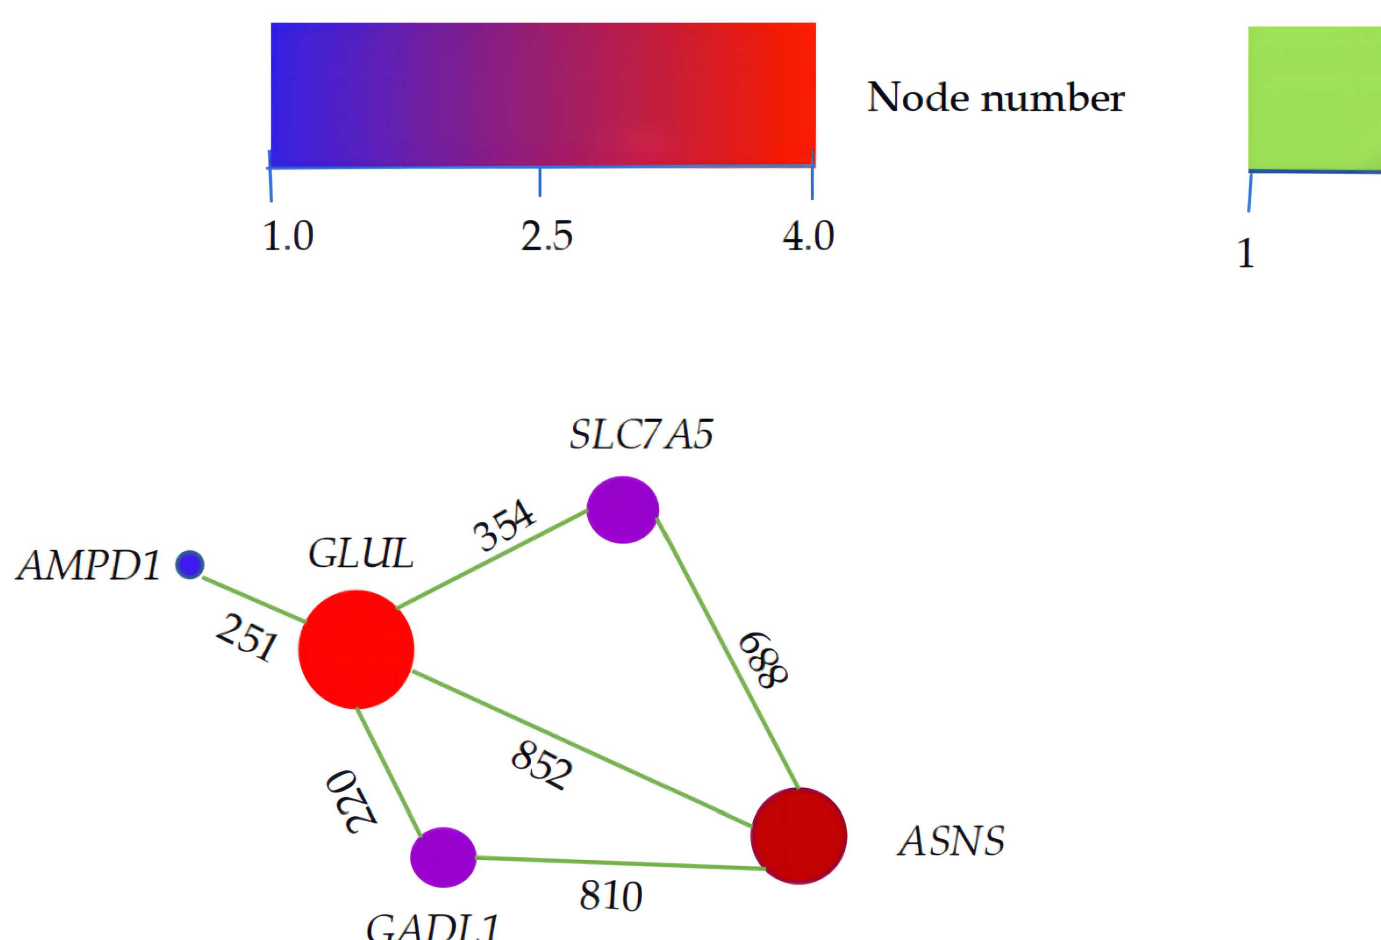
Figure 3. PPI network of candidate differently expressed genes. In the network, the higher the score of the interacting genes, the deeper the color of the lines between them, indicating a stronger interaction between two genes. The lines are directional, with the source gene pointing to the target gene along the direction of the number on the line. The larger the circle representing the gene, the more the interactions of the